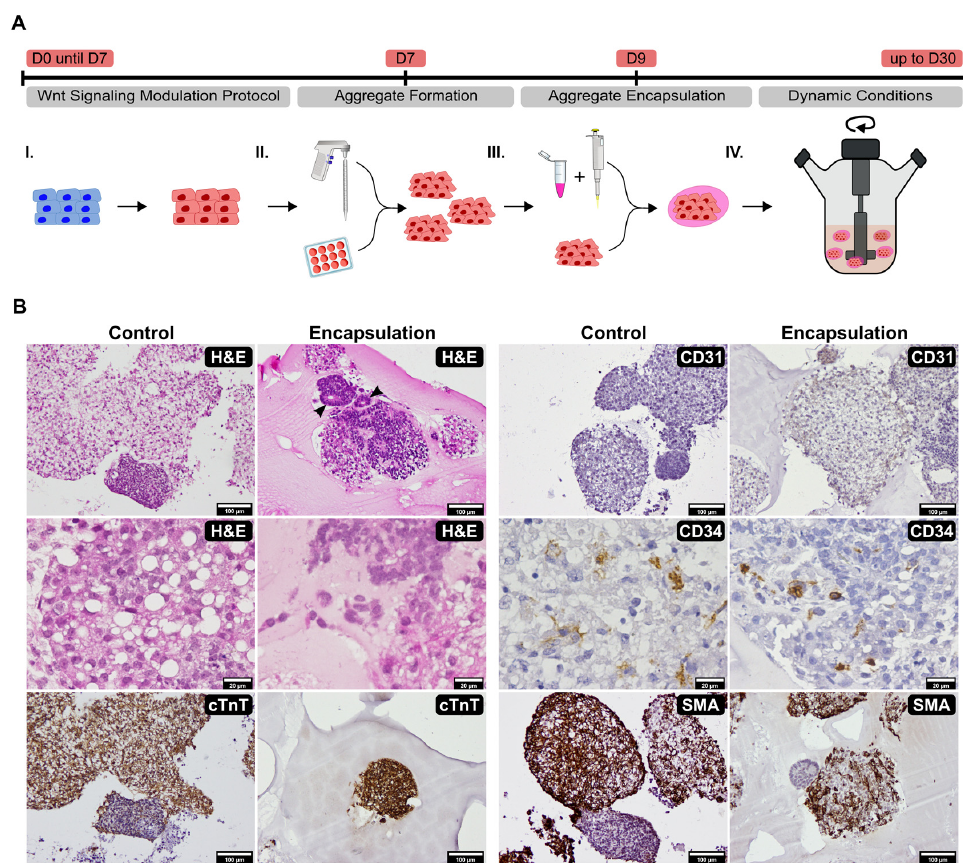
Figure 2. Matrigel encapsulation and a dynamic culture environment promotes cell migration and organization. ( A ) Scheme describing the experimental procedure. The WNT signaling modulation protocol was initiated in monolayer (I) with aggregate formation performed manually at day 7 (II). Encapsulation of aggregates with Matrigel was performed at day 9 (III) with encapsulated aggregates being cultured in dynamic conditions up to 30 days (IV). ( B ) H&E staining and immunohistochemistry panel of anti-cTnT, anti-CD31, anti-CD34, and anti-SMA markers of control and encapsulated aggregates after culture in dynamic conditions ( n = 3). H&E staining highlighted organized structures in encapsulated aggregates, in some cases showing cell polarization with the creation of lumens (black arrows) and cell migration into the Matrigel matrix. Scale bar: 100 µm, top and bottom, 20 µm mid.